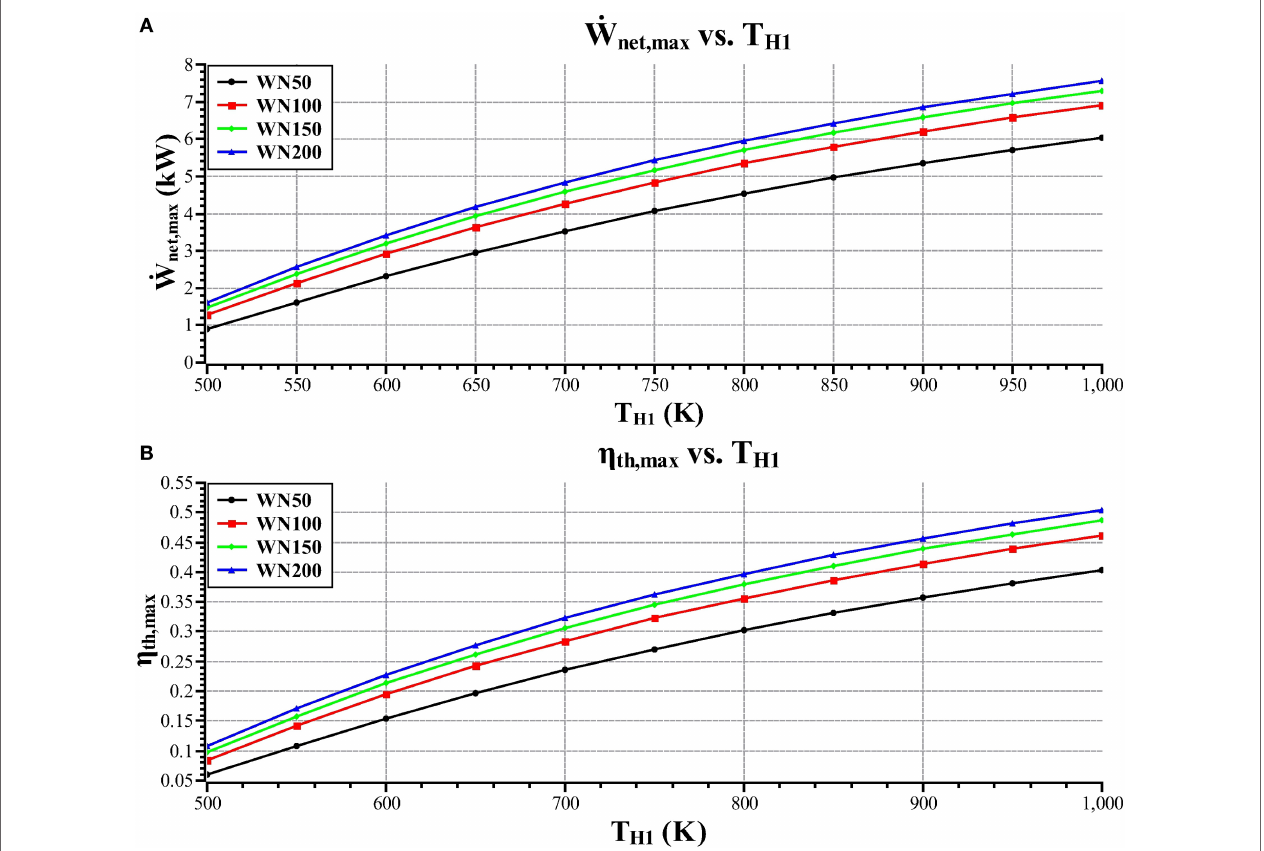
FIGURE 4 | Maximum net-work output (A) and maximum thermal efficiency (B) versus heater inlet temperature.